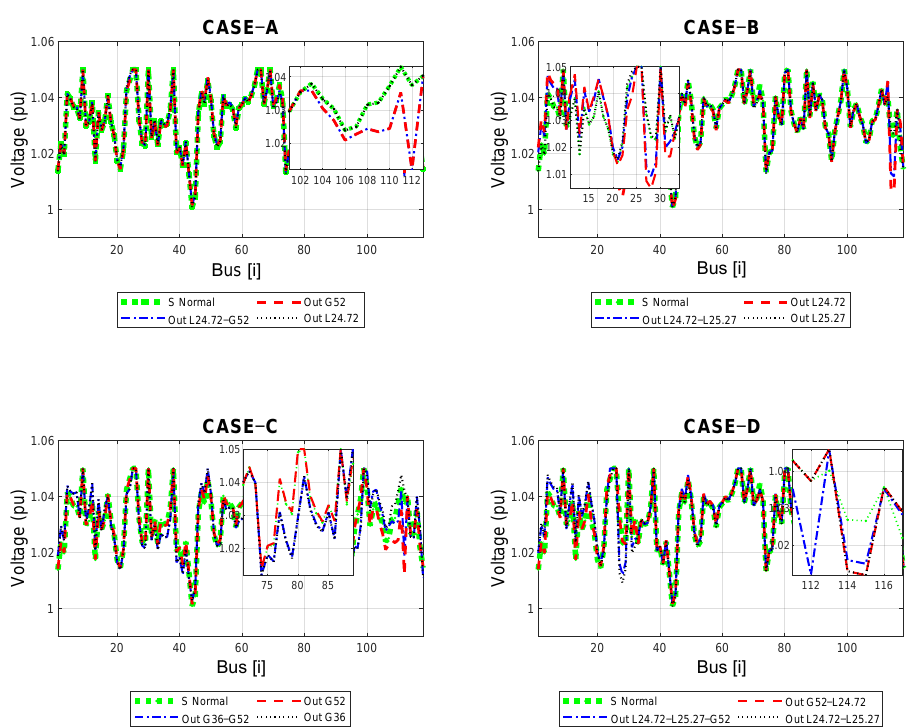
Figure 4. Voltages on IEEE 118 bus bars system subjected to